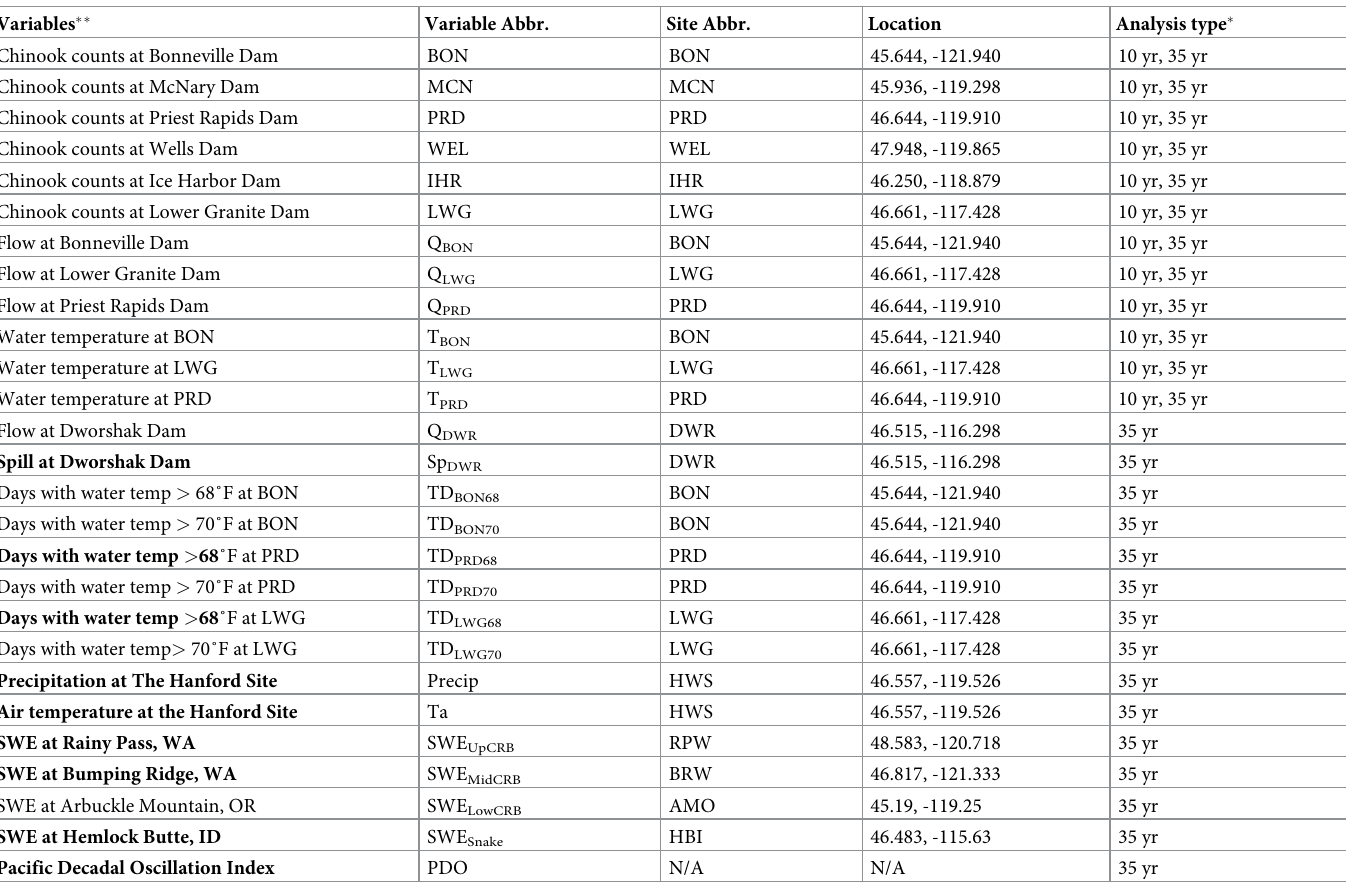
Table 1. Time-series variables included in analyses of CRB salmon counts. Chinook counts were obtained from the Fish Passage Center [39]. Water temperatures and flow rates were obtained from USACE and USGS [41, 45]. Air temperature and precipitation were obtained from the Hanford Site [42]. Snow-water-equivalent (SWE) was obtained from NRCS [44]. The PDO was obtained from NOAA